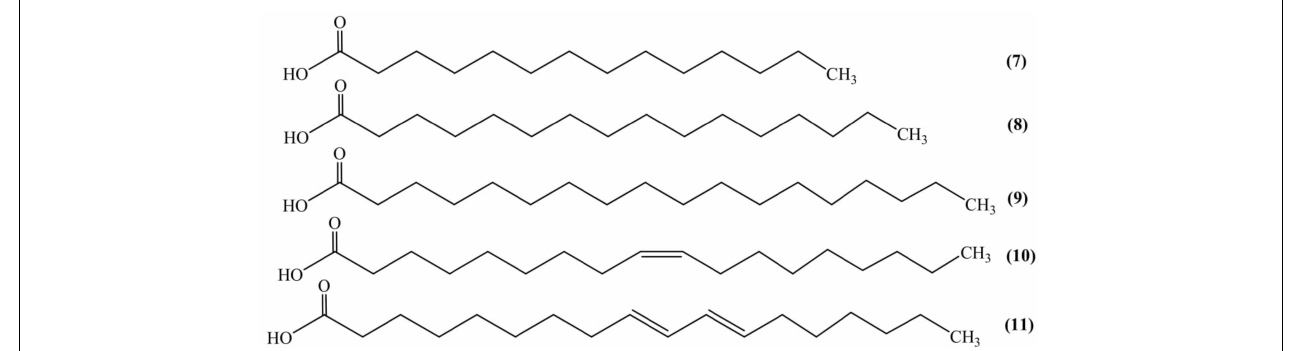
FIGURE 3 | Fatty acids.